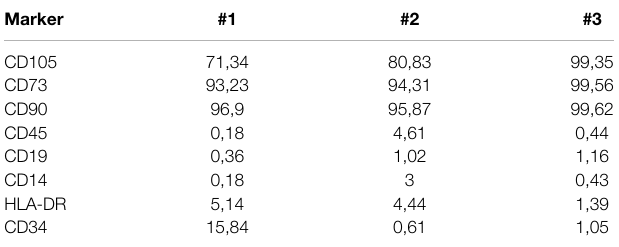
TABLE 4 | Marker expression pro fi le of MSCs.